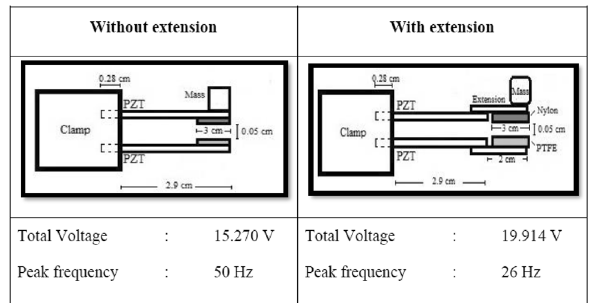
Figure 9. Performance enhancement of MT-HPTEH with nylon extension.